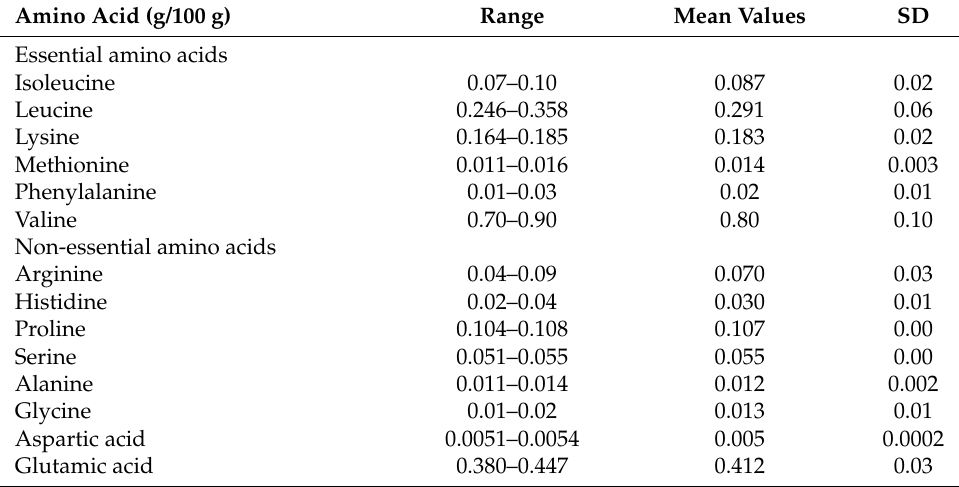
Table 4. Amino acids concentration in Halari donkey